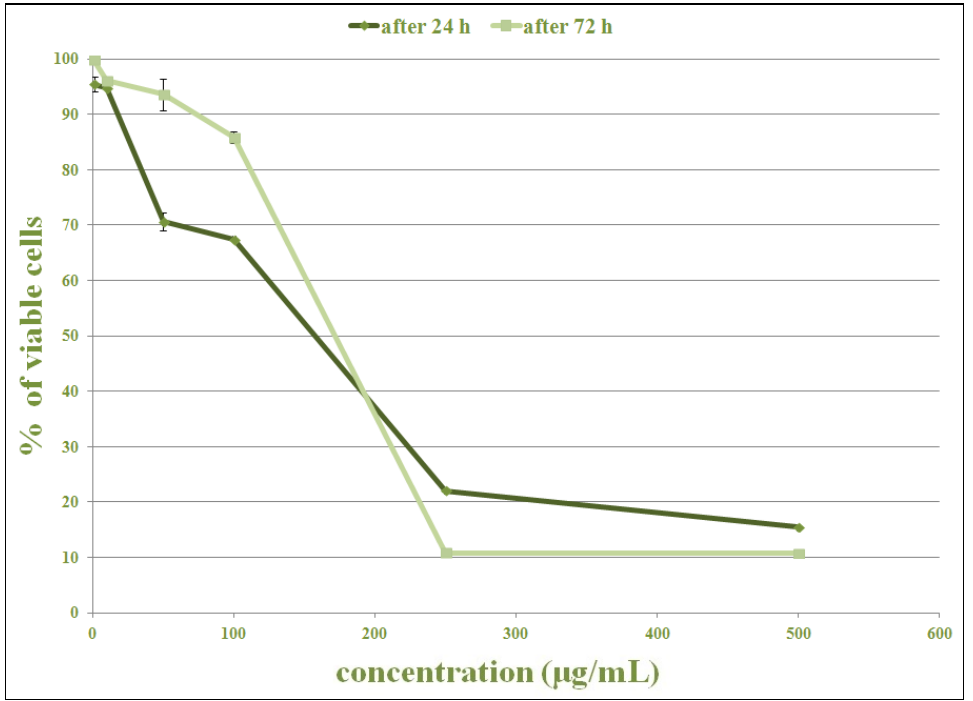
Figure 2. The cytotoxic effect of methanolic extract of O. vulgare on HCT-116 cells, 24 and 72 h after exposure. The effect was measured by MTT cell viability assay. The data are mean ± SD of three independent experiments.